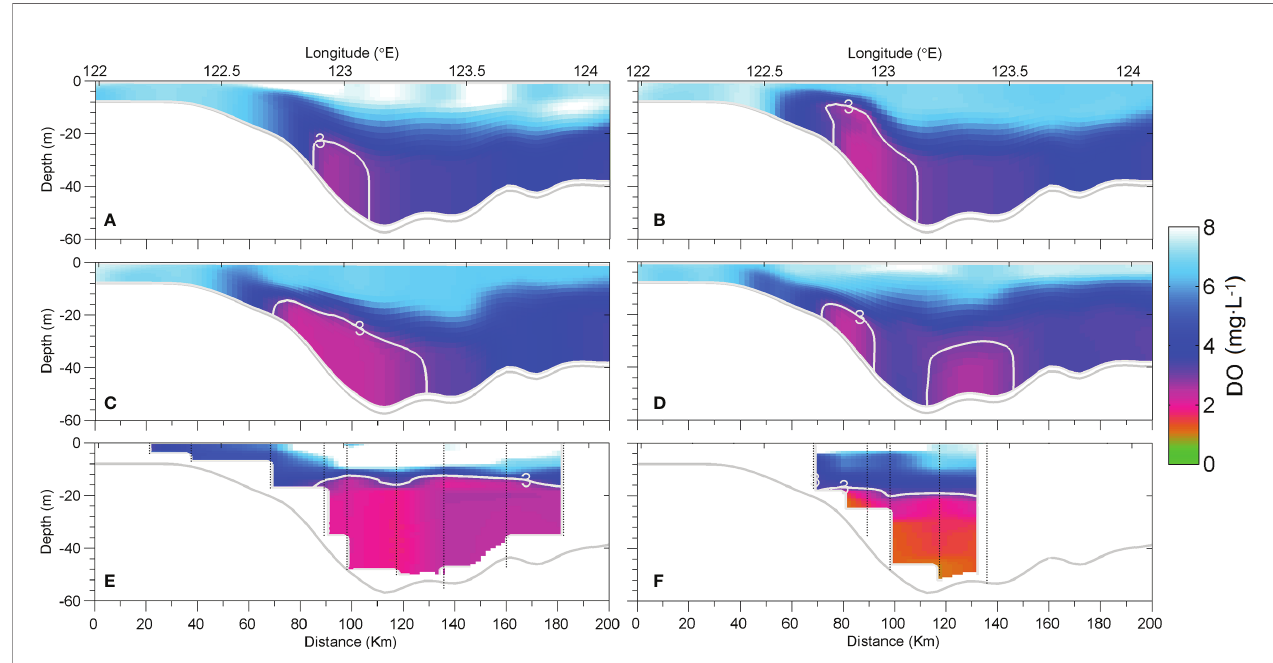
FIGURE 10 | The modeled daily-mean DO concentrations at the 31°N transect on August 22 (A) , 25 (B) , 26 (C) , and 28 (D) , 2020. Measured DO at the 31°N transect during Leg 1 (E) and Leg 2 (F) , respectively. The white contour line is for 3 mg·L − 1 .